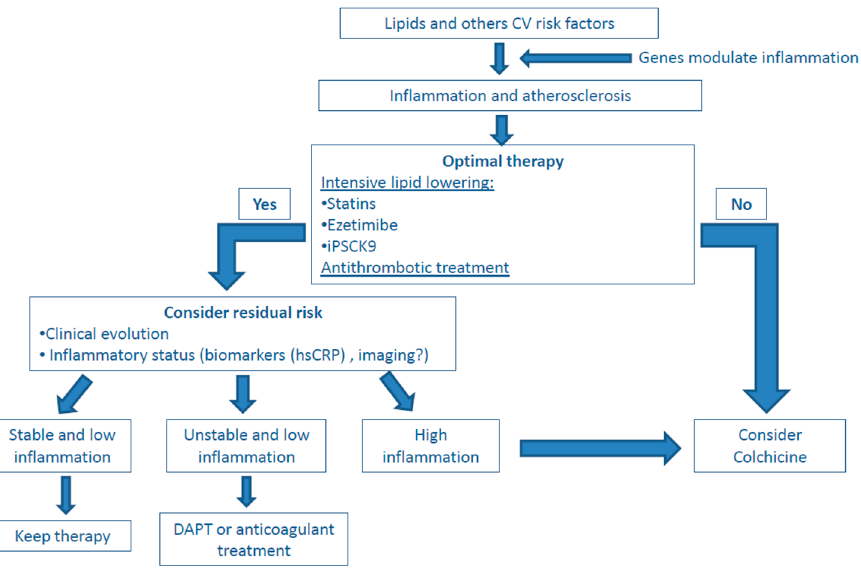
Figure 3. A potential approach to atherosclerosis and inflammation. Abbreviations: CV: cardiovascular; DAPT: double antiplatelet treatment; hsCRP: highly sensitive C-reactive protein; iPSCK9: Proprotein convertase subtilisin/kexin type-9 inhibitors.